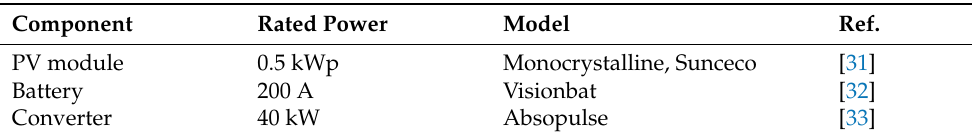
Table 1. The specifications of the selected system components.